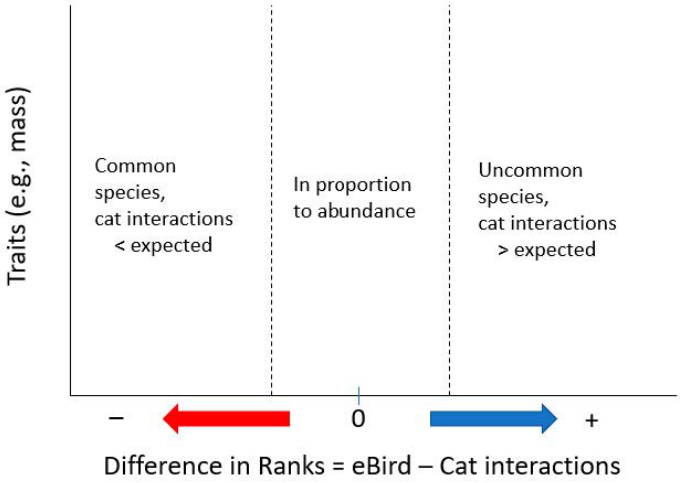
Figure 1. Schematic for evaluating differences among species admitted to the rehabilitation centers in their ranked abundances from the eBird data and the cat interaction data. When species ranked approximately the same in each list, the differences in ranks are near zero and those species are hypothesized to be admitted after cat interactions in approximately the same proportion to their abundance in the study areas. Species uncommonly reported in eBird (i.e., lower position in a ranked list, so higher numerical value for ranking) than in the rehabilitation center data are hypothesized to be species admitted to centers in higher numbers than expected based on their abundance alone. Species commonly included in eBird lists but much less often admitted to rehabilitation centers are hypothesized to be under-represented in cat interaction data relative to their abundance in the study areas.